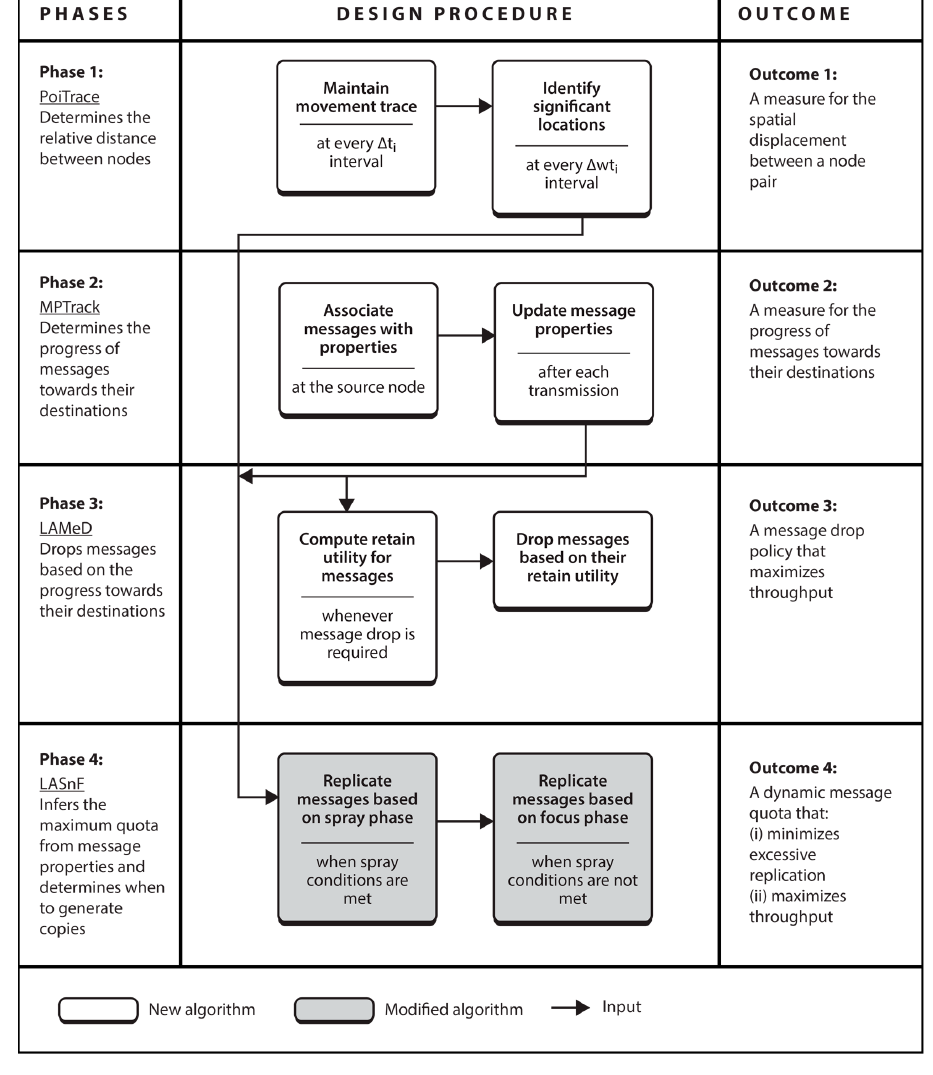
Figure 11. Functional block diagram of Locality Aware Replication (LARep).